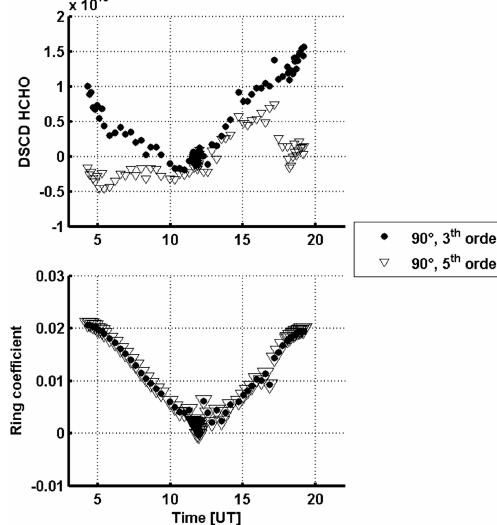
Fig. 10. Daily variation of the zenith HCHO DSCD columns (moleccm − 2 ) and of the Ring coefficients for retrievals with a 3rd and 5th order polynomial. A strong correlation is observed for HCHO and Ring when a 3rd order polynomial is used in the DOAS retrieval.